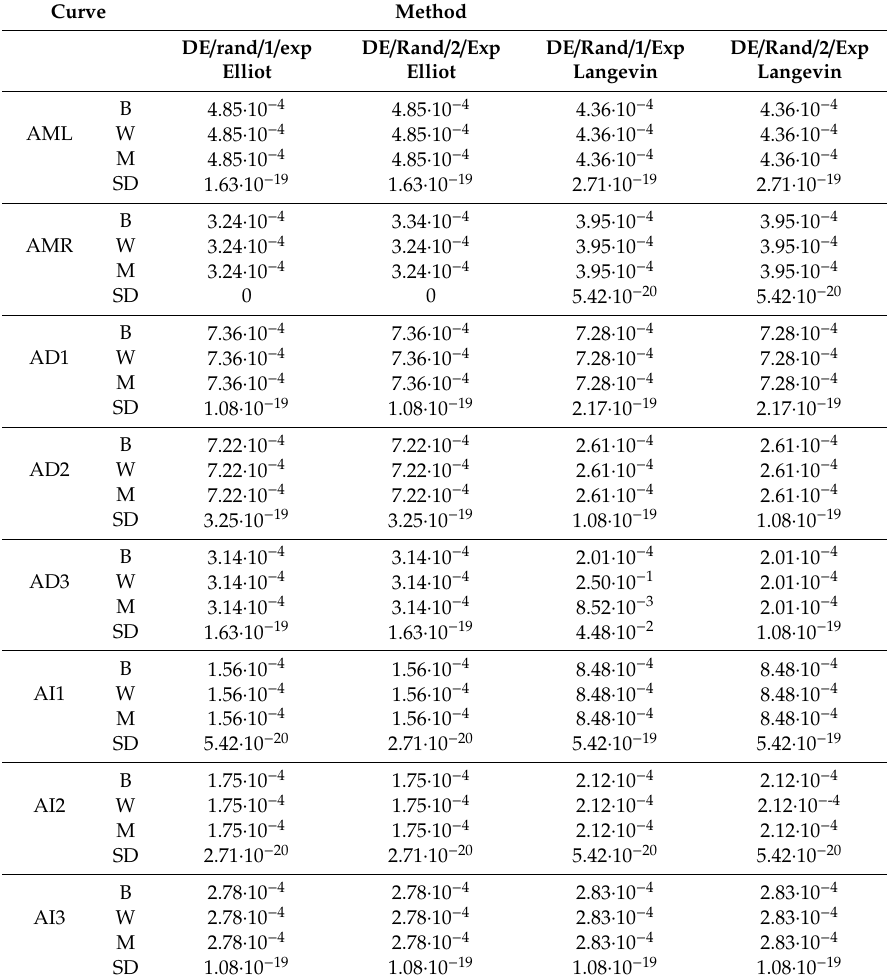
Table 7. B, W, M and SD for 30 independent runs for all Alnico curves using DE / rand / 1 / exp and DE / rand / 2 / exp for the Elliot and Langevin expressions.